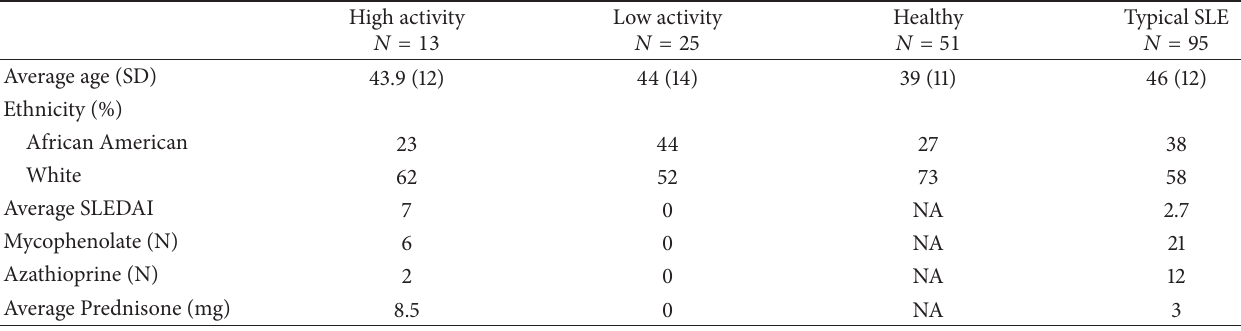
Table 1: Patient characteristics.